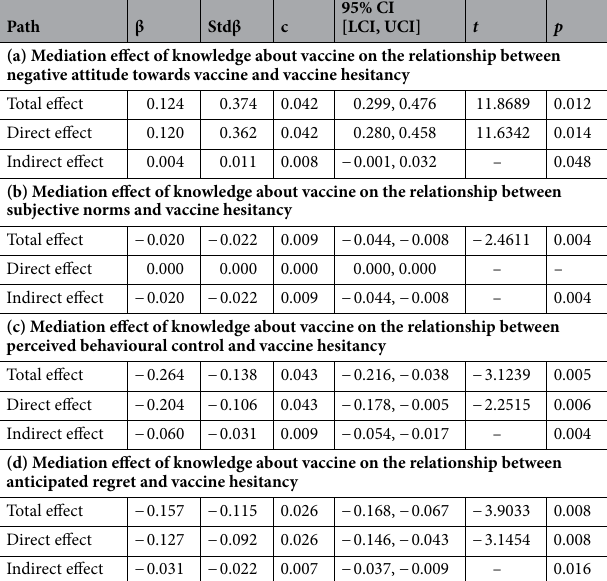
Table 7. The mediating effects of knowledge about vaccines on the relationship between TPB constructs and vaccine hesitancy. All parameters obtained from the AMOS output with the TPB dimensions: Negative attitude towards vaccine, subjective norms, perceived behavioural control and anticipated regret; β—unstandardised beta co-efficient; Stdβ—standardised beta co-efficient; SE—standard error; 95% CI—95% confidence interval with lower bounds and upper bounds [LCI, UCI]; t—t value, p —shows the significant level.